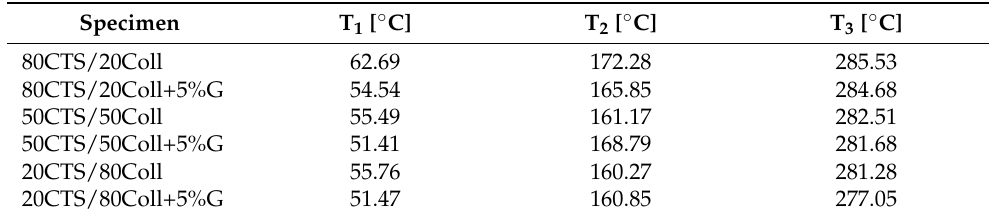
Table 2. Parameters of the thermal decomposition of the scaffolds for the maximum temperature of the obtained peaks on TG-DTG spectra.